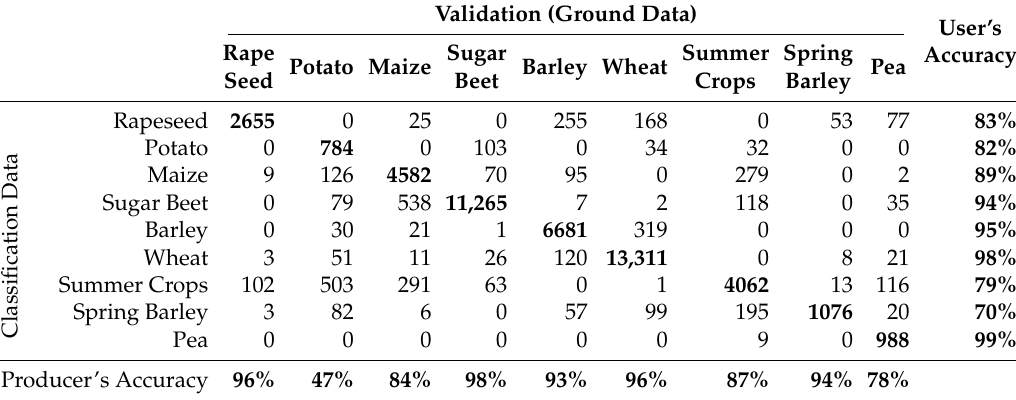
Table 6. Error Matrix of the multi data approach (MDA) land use / land cover (LULC) classification with optical data shown in Figure 1 [71]. The classification was performed using the MDA described by [14], Overall Accuracy: